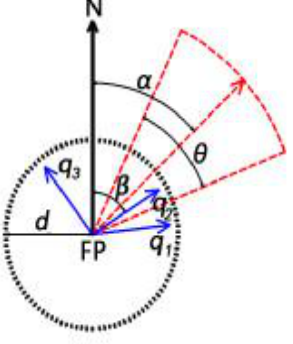
Figure 7. The direction constraint of the distance query (3)For Direction, it queries the video object for which the shooting azimuth is in accordance with the direction